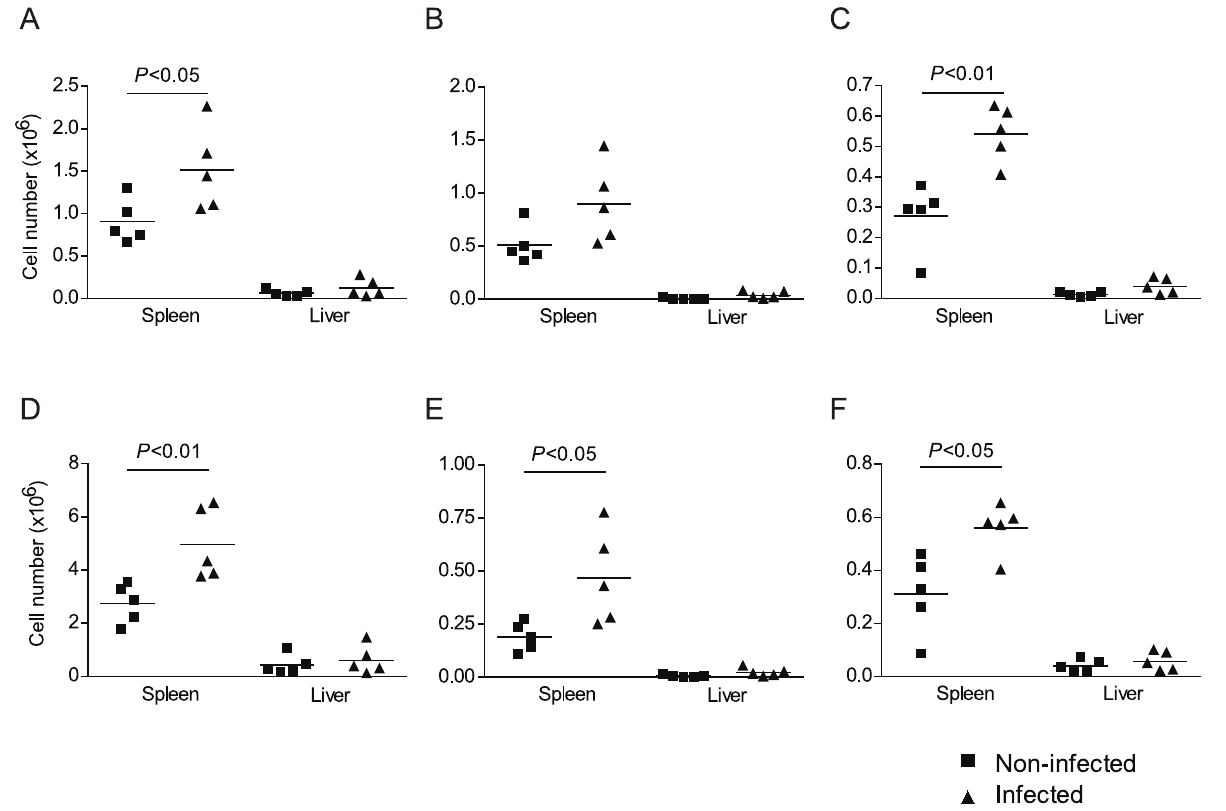
Figure 3. Numbers of splenic and hepatic CD11c + and CD11b + cells during pre-patent schistosome infection. A, Flow cytometric analysis of cells isolated from the spleen or liver of 4 week S. mansoni infected or non-infected mice. Cells were gated and the absolute number of cells of each phenotype was calculated as described in Methods. Total numbers of CD11c + (A), CD11c + MHC class II + (B) or CD11c + CD86 (C) cells per organ. Total numbers of CD11b + (D), CD11b + MHC class II + (E) or CD11c + CD86 + (F) cells per organ. Horizontal bars represent the mean of 5 independent mice.